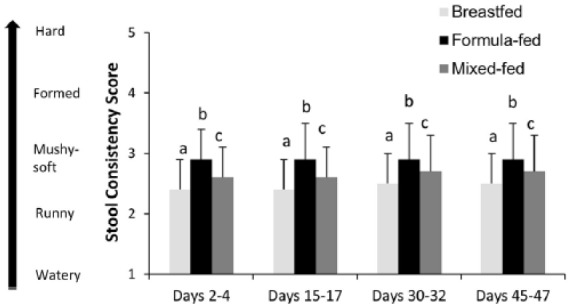
Stool consistency score for infants according to feeding groups at time points of evaluation. Mean ± SD stool consistency score of infants at each study visit. ANOVA followed by pairwise comparisons was conducted to compare groups at each time points. Bars with different letters (a, b, c) are significantly different (P < .05). Breastfed, group of infants who were exclusively breastfed; formula-fed, group of infants who were exclusively fed with formula containing higher sn-2-palmitate and oligofructose (sn-2+OF); mixed-fed, group of infants who were mixed fed with breast milk and sn-2+OF formula.